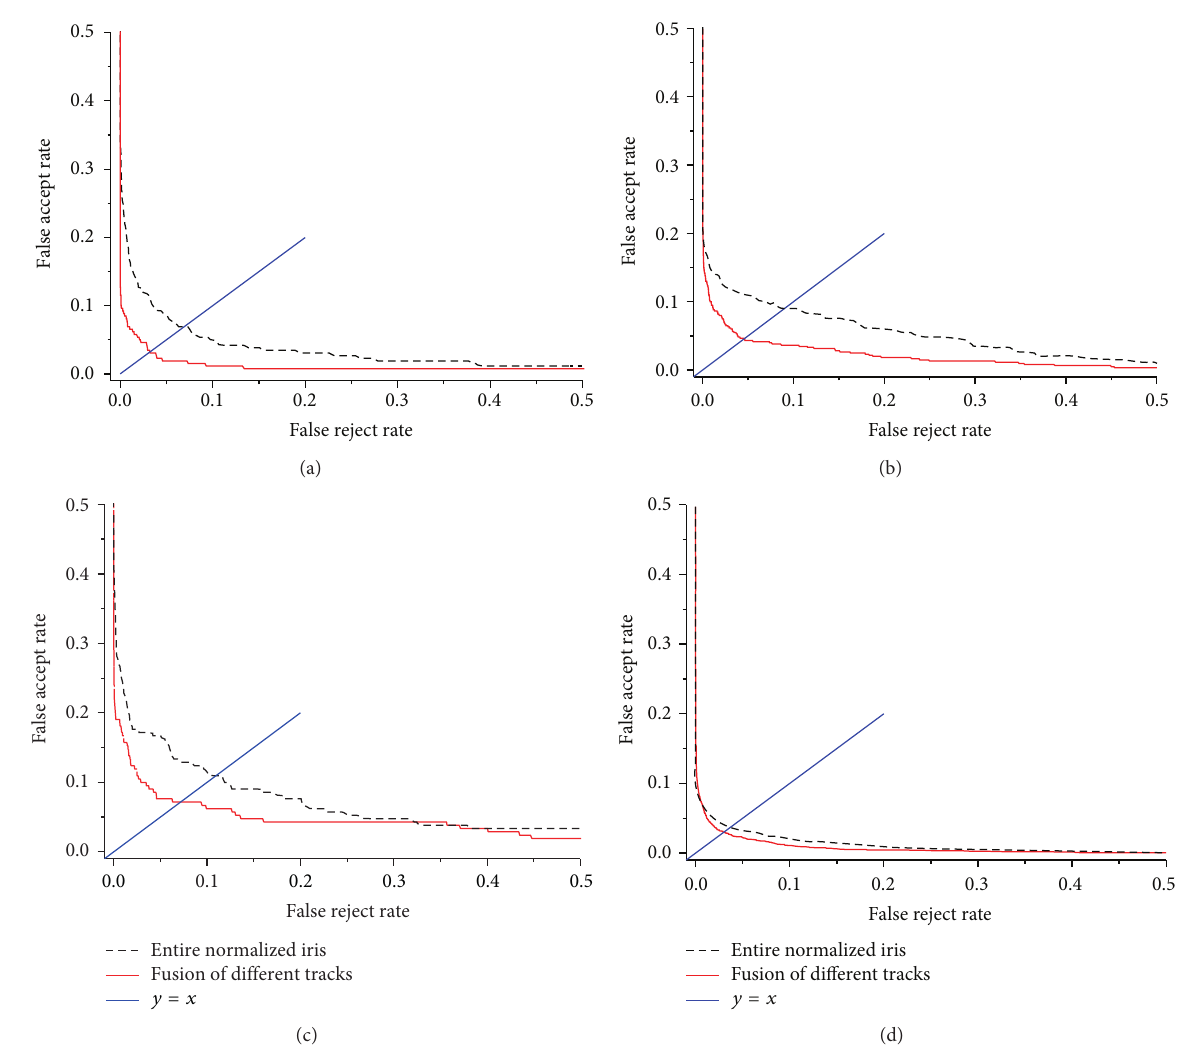
Figure 12: ROC curves for (a) CASIA-V1, (b) CASIA-V3 Interval, (c) MMU-V1 and (d) JLUBRIRIS-V1 databases. Table 9: Description of process fragile